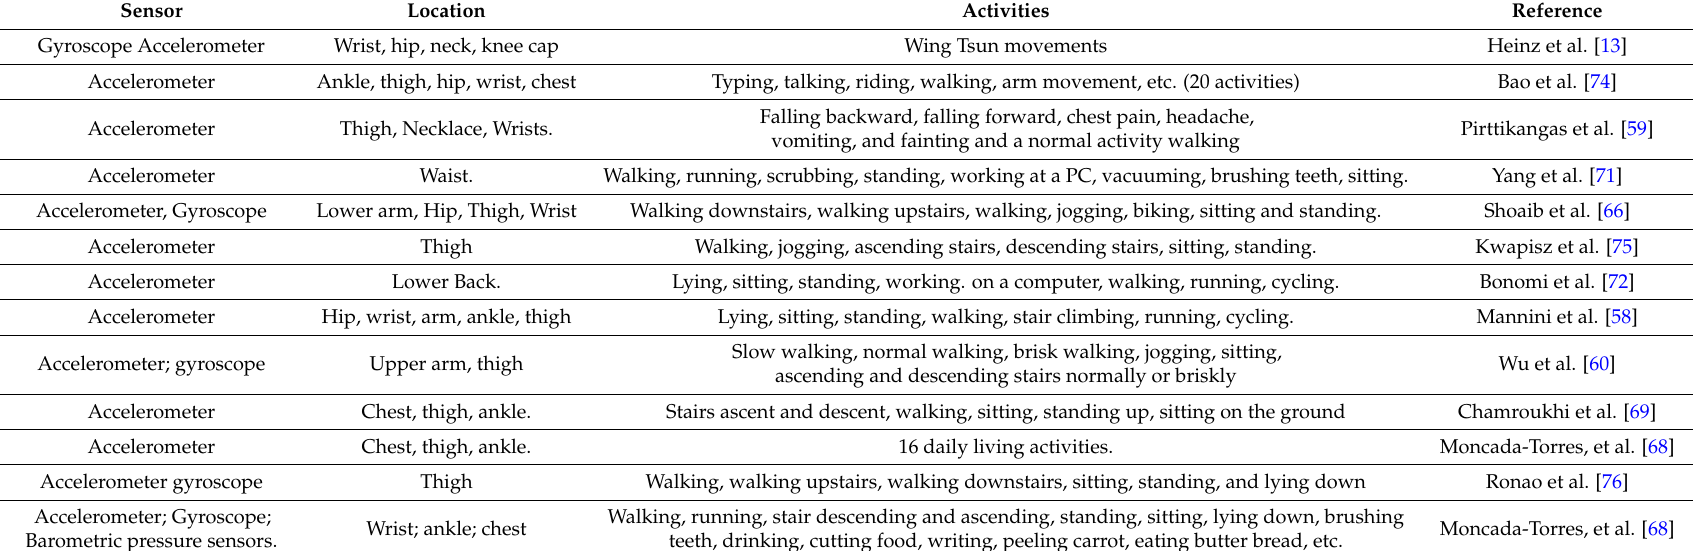
Table 3. Summary of research on sensor placement for